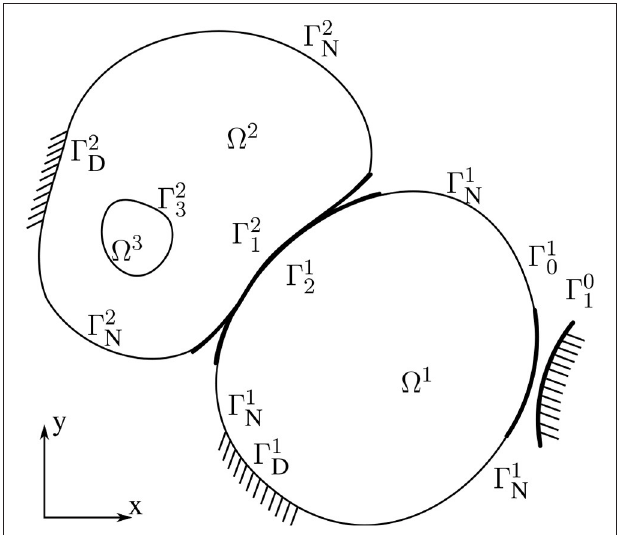
FIGURE 1 | Schematic illustration of the geometry and of the notation for the 2D case of N = 3 subdomains in contact including a rigid obstacle.